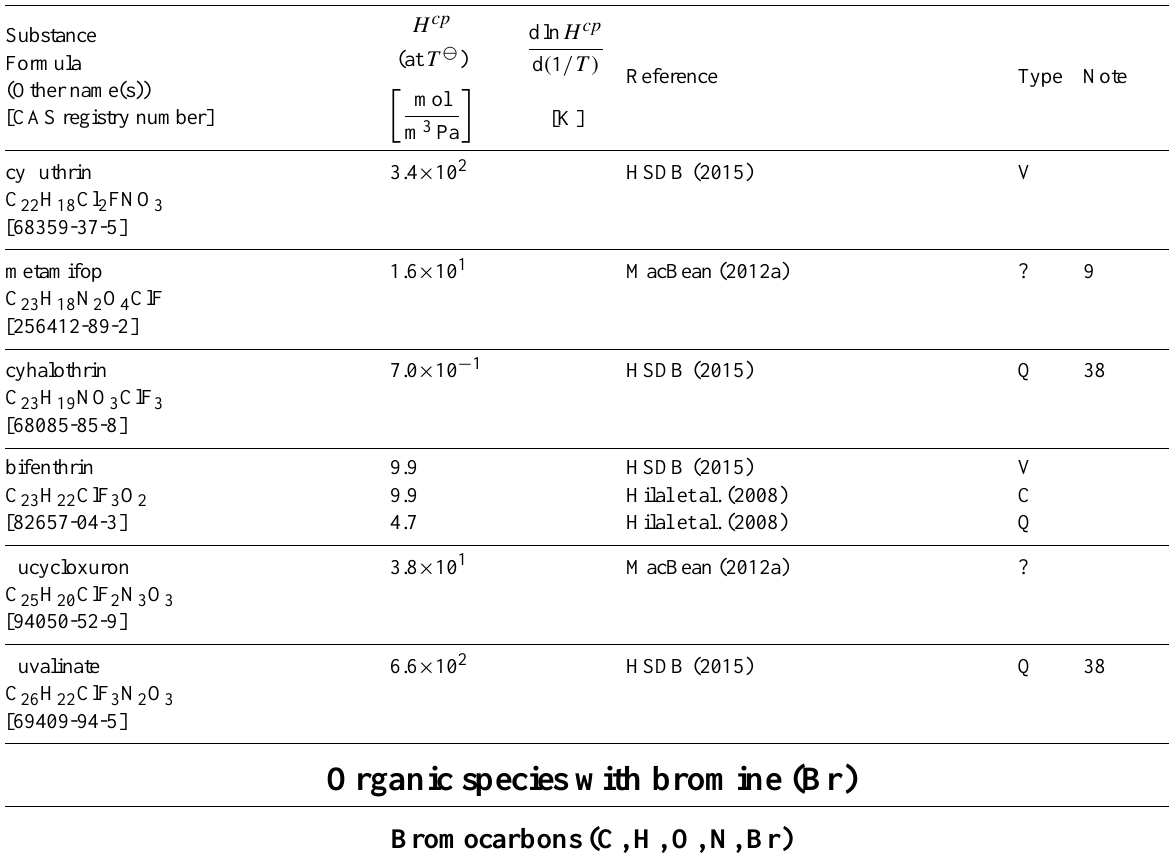
Table 6: Henry’s law constants for water as solvent